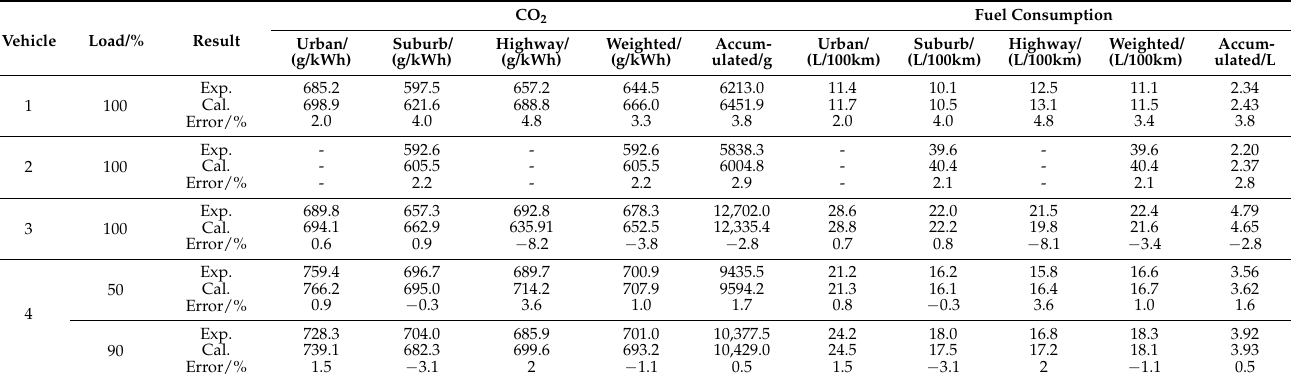
Table 4. Experimental and calculated results, and the relative error.